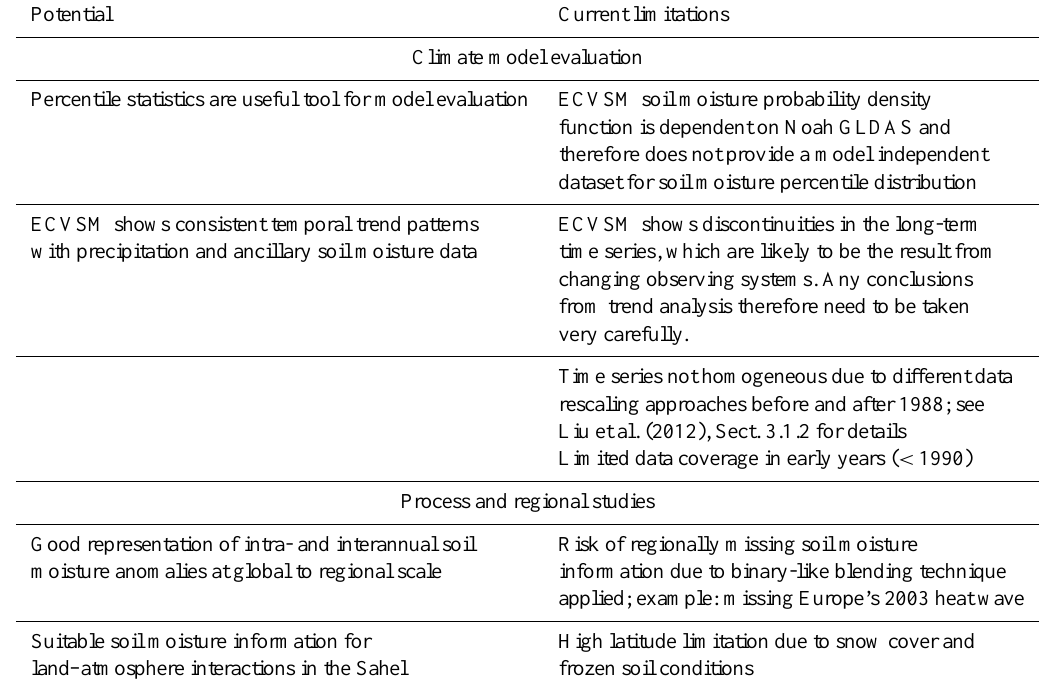
Table 1. Summary of potential and limitations of ECVSM for climate modeling